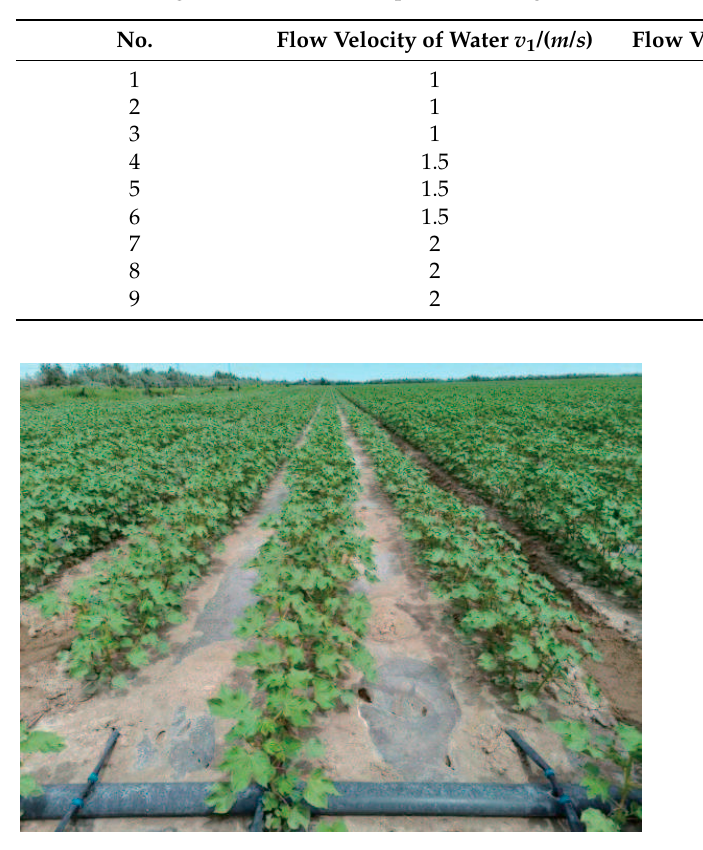
Table 2. Working conditions for the experiment design.